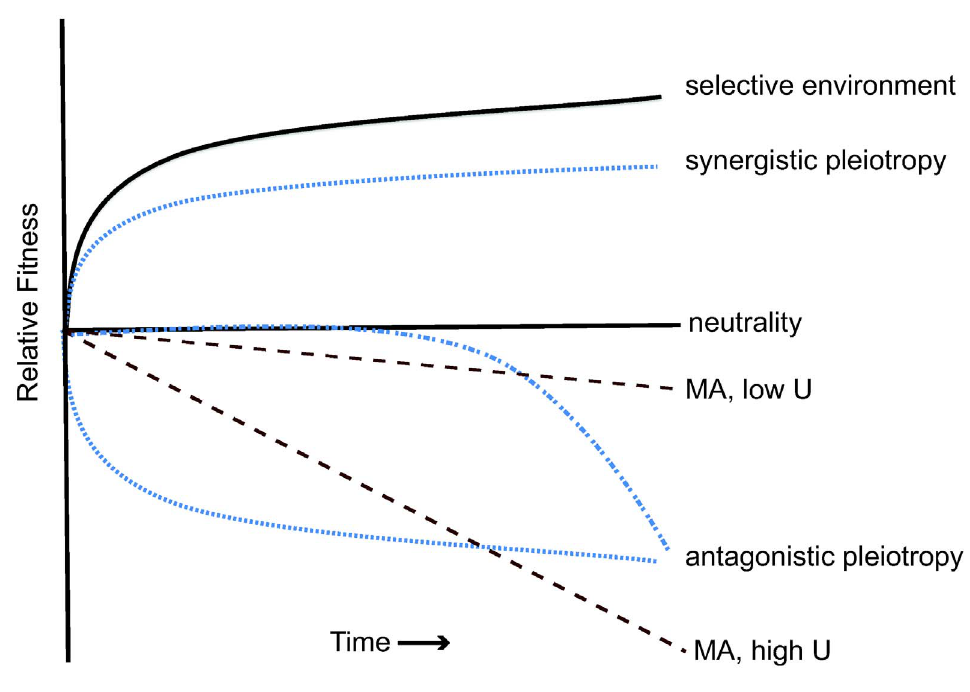
Figure 1. Hypothetical dynamics of fitness in foreign environments by pleiotropy or mutation accumulation during long-term adaptation. Prolonged adaptation to one environment leads to decelerating fitness gains in the selective environment (solid black line), as beneficial mutations become limiting. Consequences of this adaptation for fitness in other environments may take different forms. No net change may occur if beneficial mutations generate no or inconsistent side effects (neutrality). However, the same mutations responsible for adaptation may also increase fitness in other environments (synergistic pleiotropy, dotted line), may decrease fitness in foreign environments at an equivalent rate if antagonistic effects correlate with selected effects (antagonistic pleiotropy, dotted line), or may decrease fitness at an increasing rate if subsequent mutations generate greater tradeoffs (antagonistic pleiotropy, dashed and dotted line). The uncertainty of the form of pleiotropic effects reflects a general lack of understanding of how mutations interact to affect fitness, particularly over the long term. Mutation accumulation (MA) in traits hidden from selection is expected to reduce fitness randomly but linearly on average, more slowly during evolution at a low mutation rate (MA, low U) or more rapidly at a high mutation rate (MA, high U). Evidence of all processes is now evident in this latest study of the evolution of diet breadth in